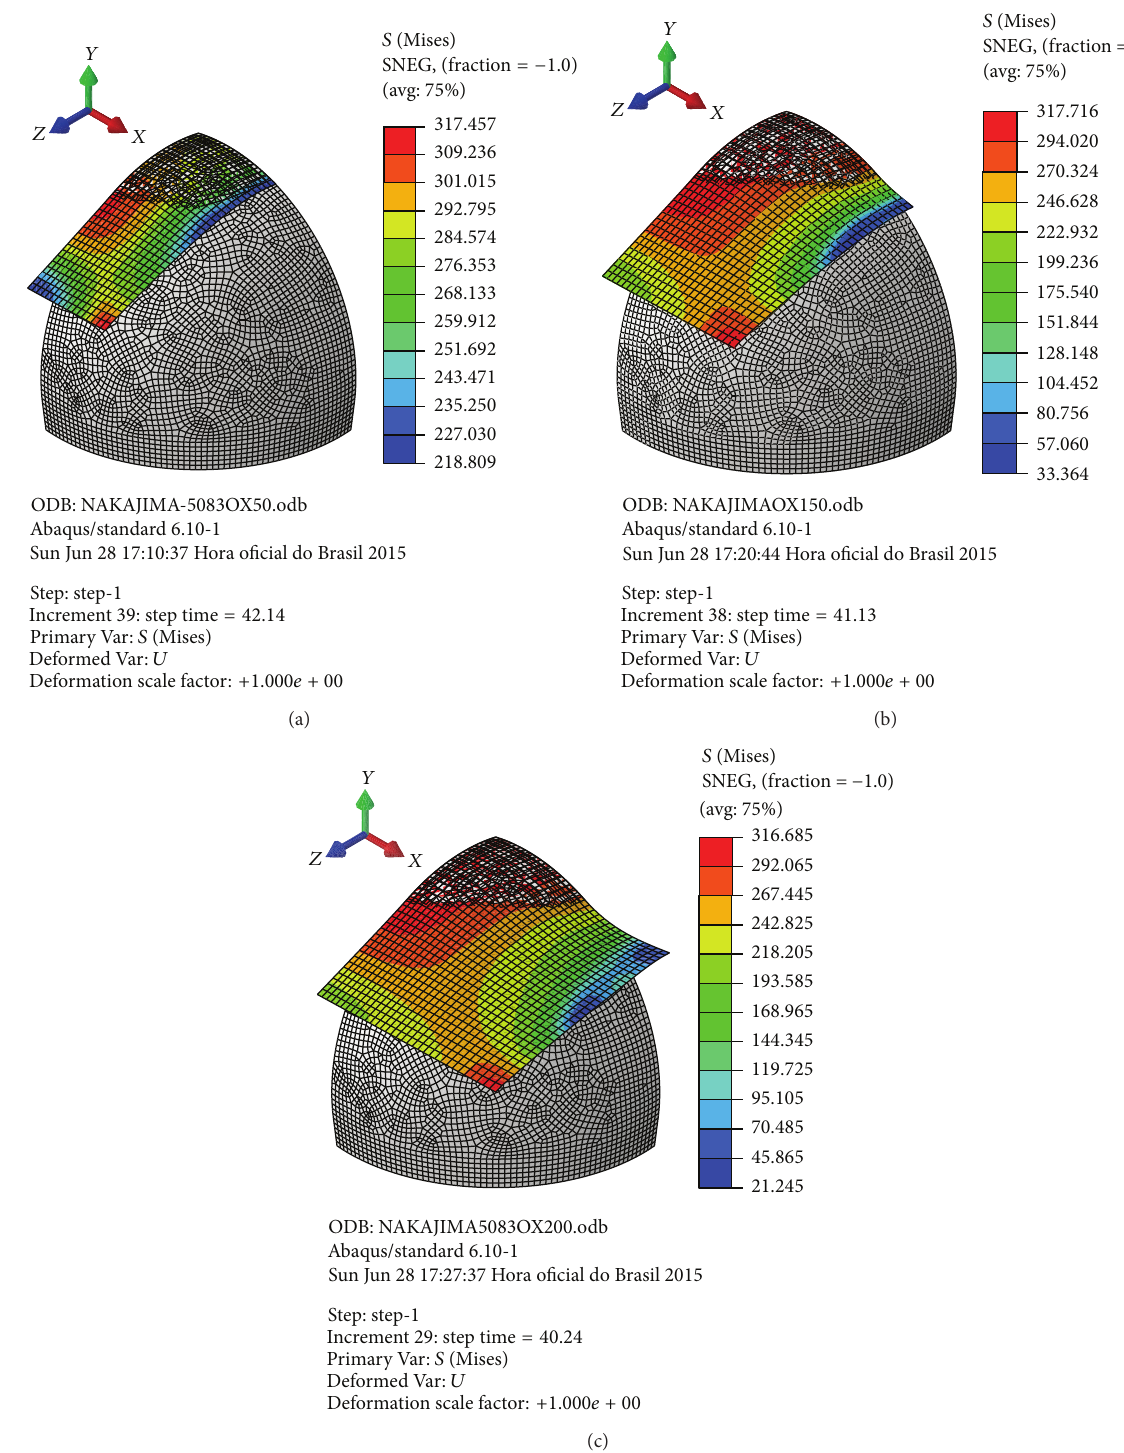
Figure 31: Von Mises stress distribution in Abaqus for the Nakajima tests in CS1 condition: (a) 100mm, (b) 150 mm, and (c) 200